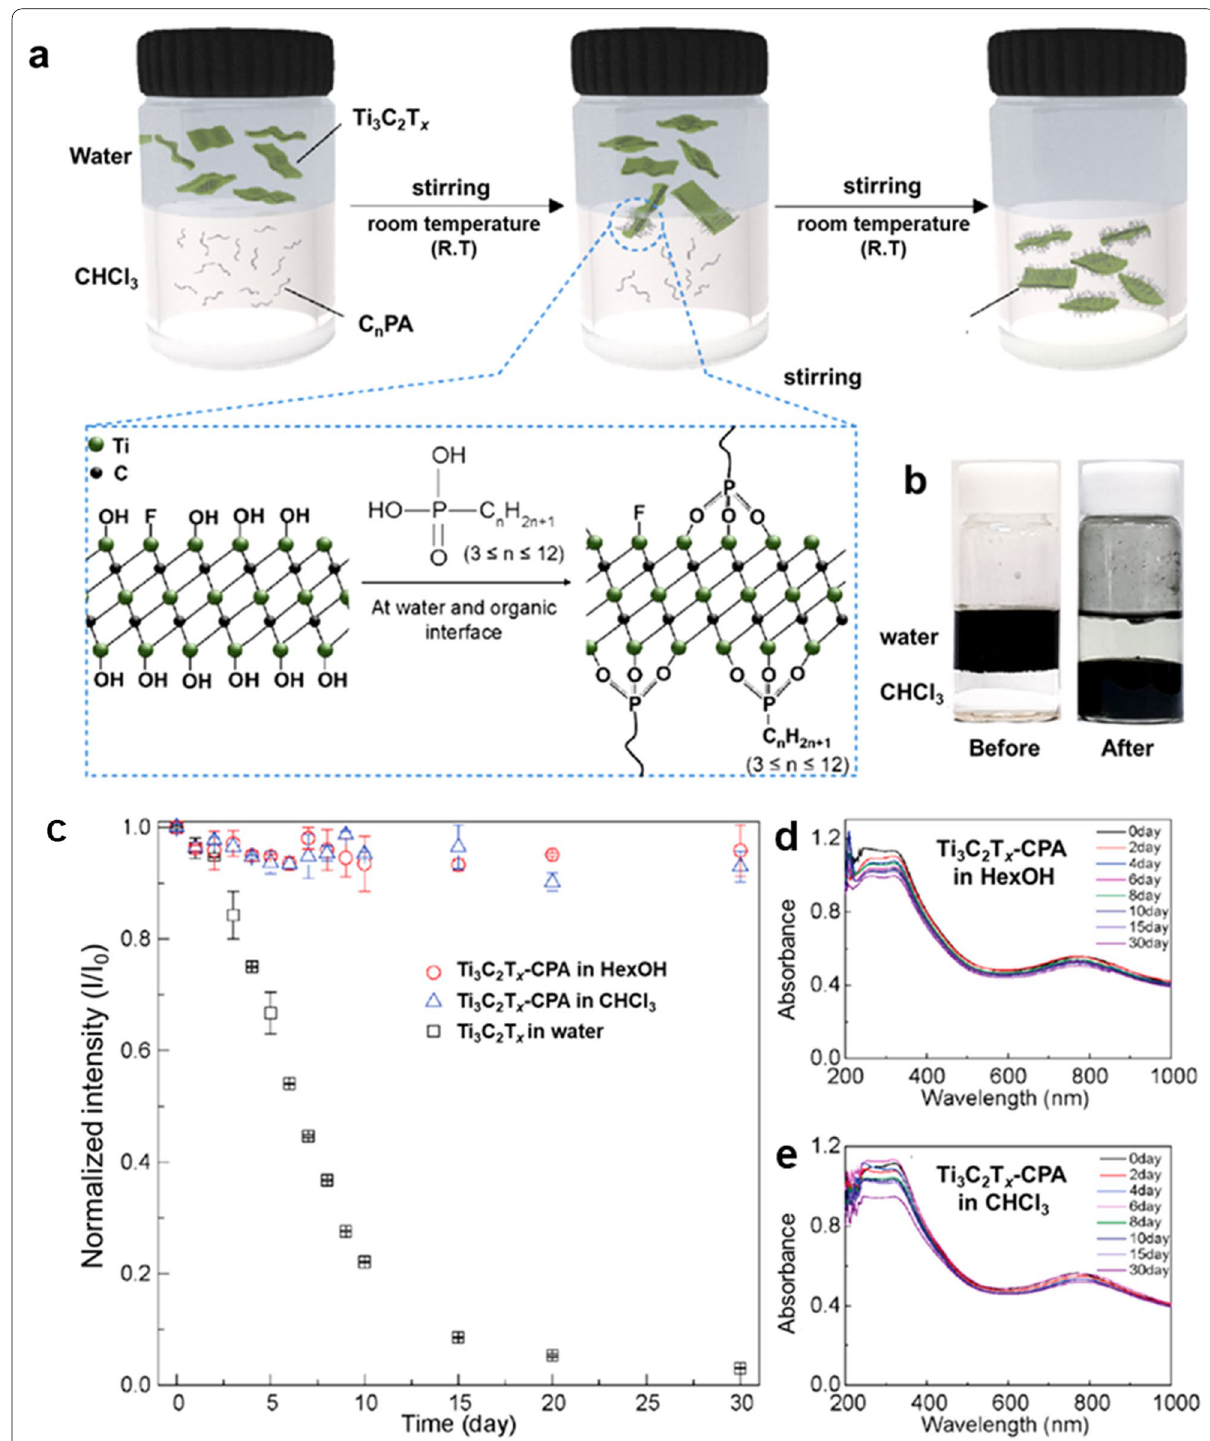
Fig. 11 a Schematic illustration of simultaneous interfacial chemical grafting reaction and phase transfer for preparing a stable nonpolar Ti 3 C 2 T x dispersion. b Photographs of Ti 3 C 2 T x dispersion in immiscible water and chloroform phases before and after the reaction. c Normalized intensity of the peak at around 760 nm for pristine Ti 3 C 2 T x in water, Ti 3 C 2 T x -C 12 PA in hexanol, and Ti 3 C 2 T x -CPA in chloroform as a function of storage time. UV visible absorbance spectra of d Ti 3 C 2 T x -CPA in hexanol, and e Ti 3 C 2 T x -CPA in chloroform, respectively. a – e Reproduced with permissions from − ref. [40]. Copyright (2019), American Chemical